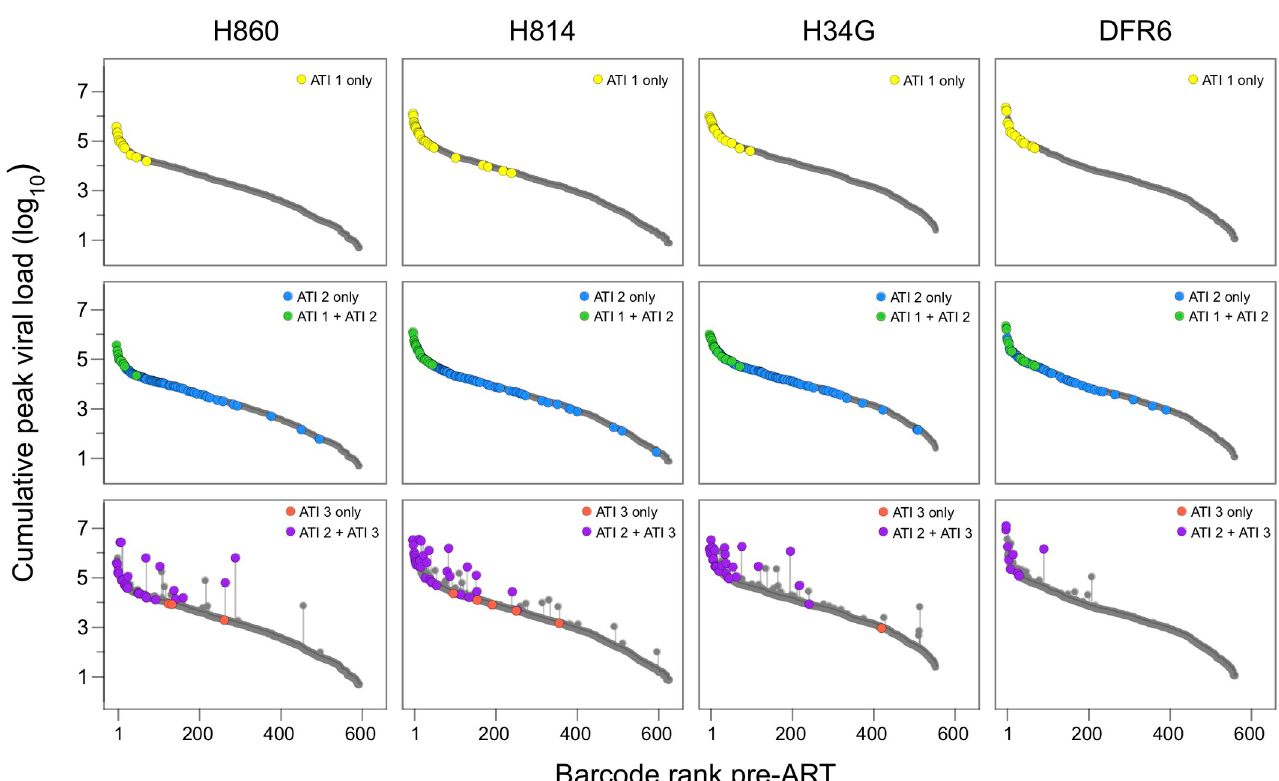
Fig 3. Reactivation of variants based on viral replication. Each row depicts reactivation of lineages in the first (top panels), second (middle panels), or third (bottom panels) treatment interruption. The grey points depict the cumulative peak viral loads (pre-ART plus any previous ATI) attributable to each variant and rank-ordered based on their relative frequency at d10. The dark grey lines depict the pre-ART barcode viral loads and the vertical grey lines correspond to the contribution of replication during ATIs to cumulative barcode viral loads. Barcodes detected at ATI-1 are highlighted in yellow; green if also found in ATI-1; and blue if unique to ATI-2. Barcodes detected during ATI-3 are purple if also detected in ATI-2 and red if unique to ATI-3.